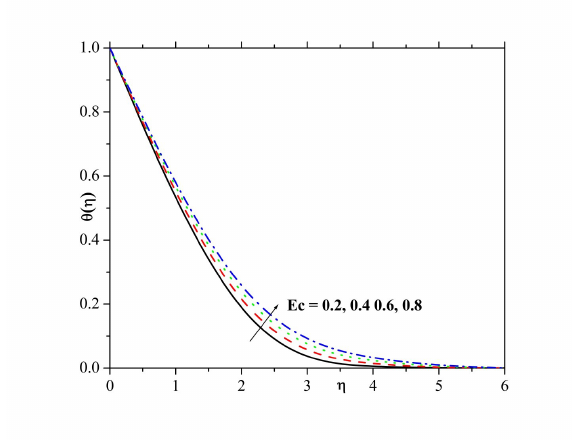
Fig. 12: Influence of Ec on θ ( η )